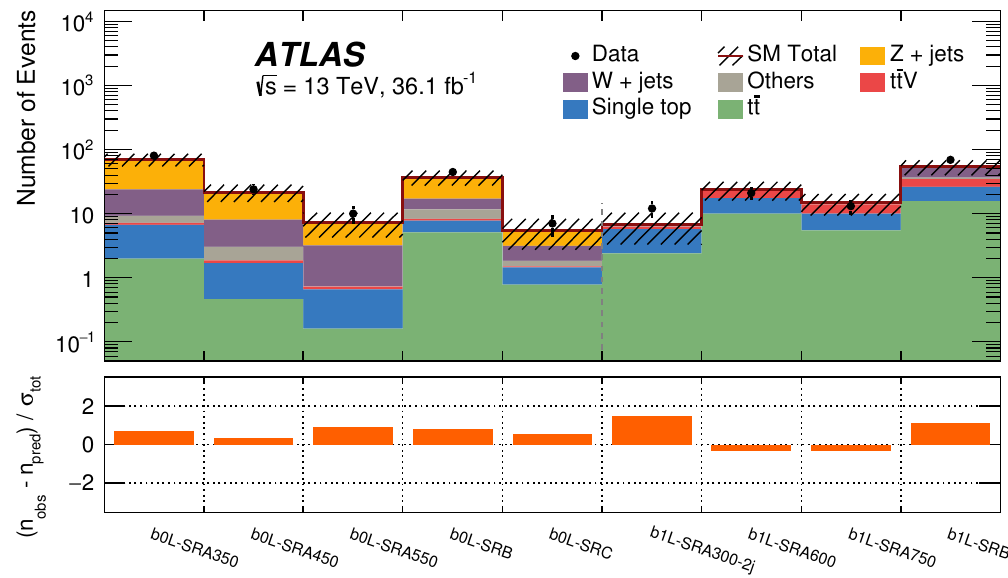
Figure 5. Results of the likelihood (cid:12)t extrapolated to the SRs associated with the b0L and b1L analyses. The normalization of the backgrounds is obtained from the (cid:12)t to the CRs. The upper panel shows the observed number of events and the predicted background yields. The contributions from diboson, multijet and rare backgrounds are collectively called \Others". All uncertainties de(cid:12)ned in section 7 are included in the uncertainty band. The lower panel shows the pulls in each SR, where (cid:27) tot is the error on the background estimation as a sum in quadrature of the systematic uncertainty and the statistical uncertainty on the